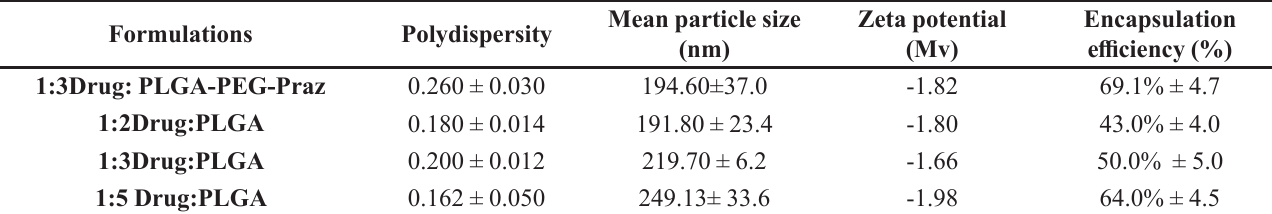
TABLE I - Polydispersity (±SD), mean (±SD) particle diameter, zeta potential, and encapsulation efficiency (±SD)of the various nanoparticles